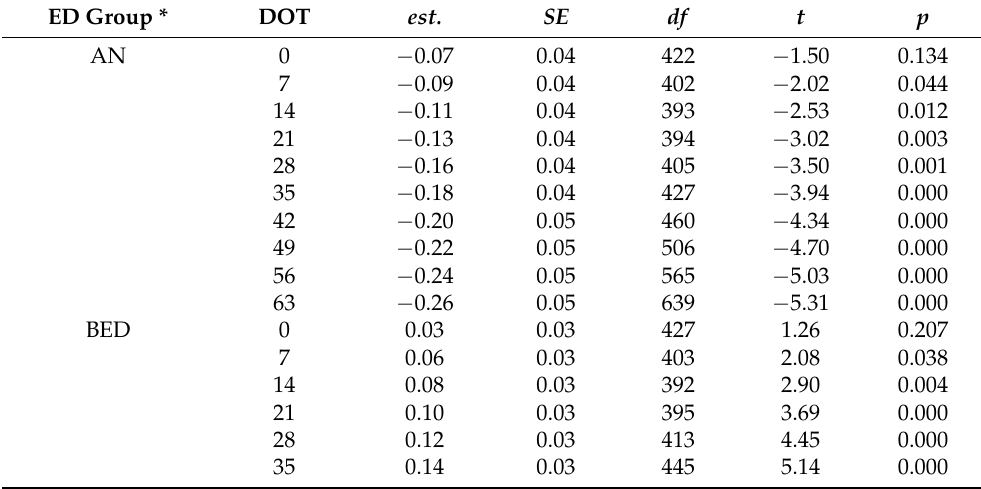
Table A3. LME pairwise comparisons (women–men) for change in weight outcomes